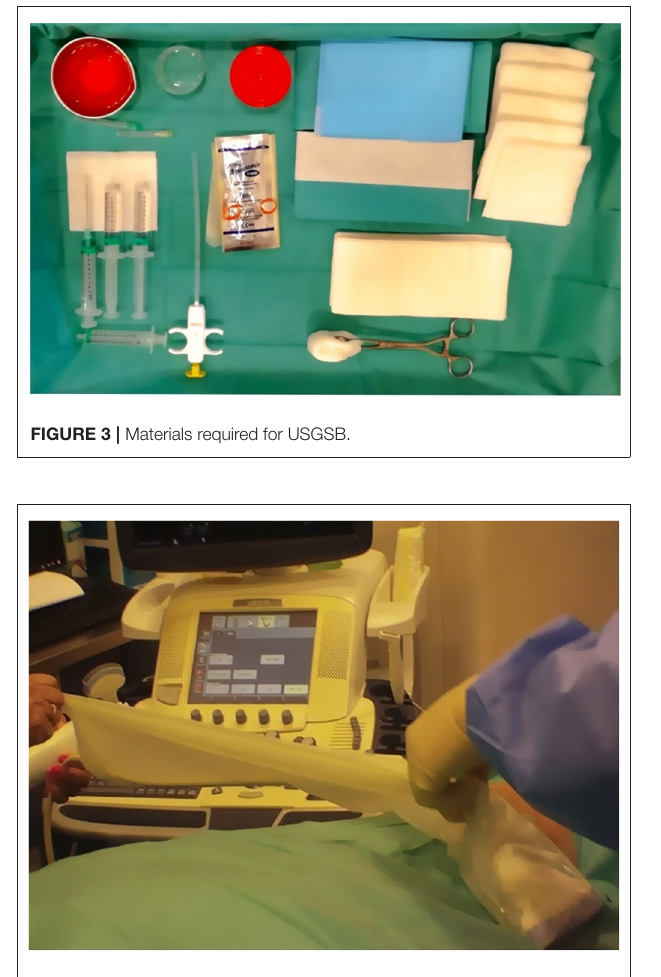
FIGURE 4 | Field and probe cable protection.